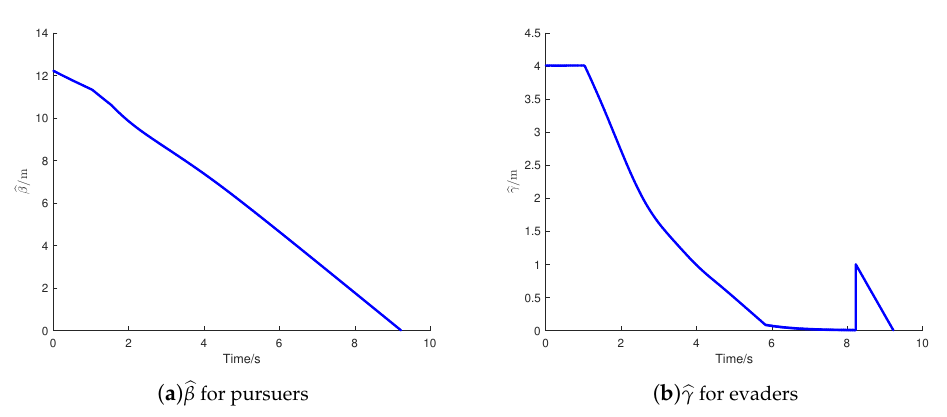
Figure 4. The values of (cid:98) β and (cid:98) γ of multi-player PE games.